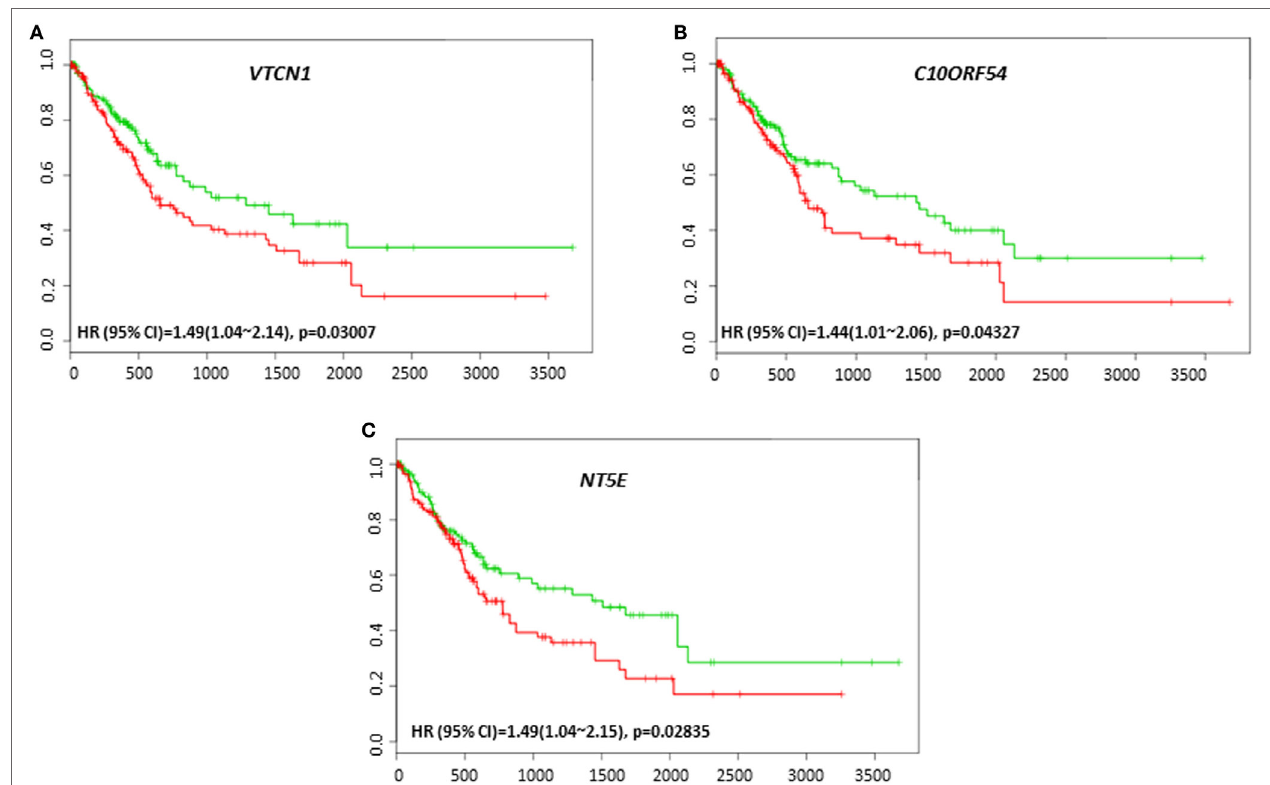
FigUre 4 | Relationship of immune modulators and recurrence-free survival in HCC patients. Kaplan–Meier curves produced using the SurvExpress for the analysis of recurrence-free survival and gene expression of (a) VTCN1 , (B) C10ORF54 , and (c) NT5E in HCC patient samples. Green curve represents low-risk group, while red curve represents high-risk group. The study time (months) is presented in the x -axis. The insert shows the hazard ratio, confidence interval, and Log-Rank Equal Curves p value. Markers ( + ) represent censoring